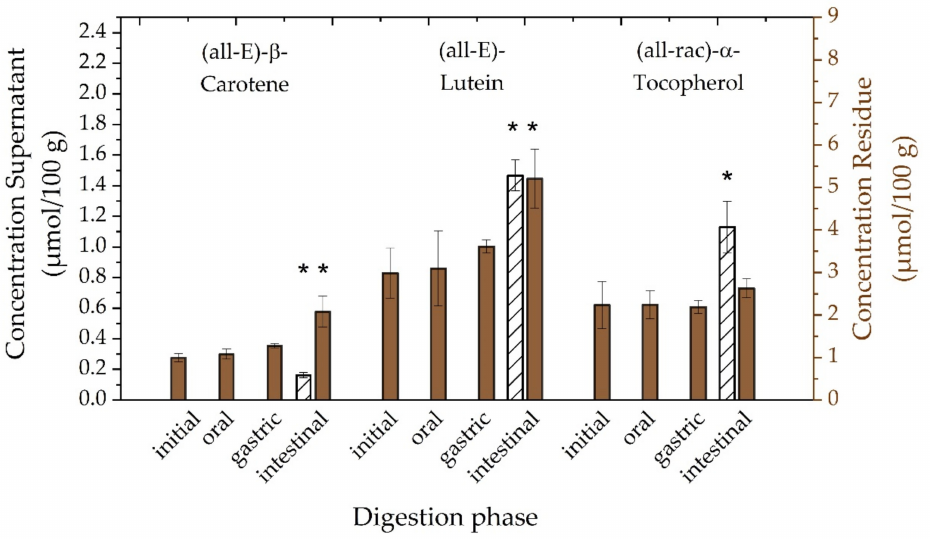
Figure 5. Dependence of concentrations of (all-E)- β -carotene, (all-E)-lutein, and (all-rac)- α -tocopherol after in vitro digestion in aqueous supernatants (left ordinate axis, white bars) and in solid residues (right ordinate axis, brown bars) on digestion phases. One-way ANOVA with Tukey-HSD post hoc test; asterisks in the same line indicate significant differences ( p < 0.05) between initial phase and oral, gastric, intestinal phases in both supernatant and